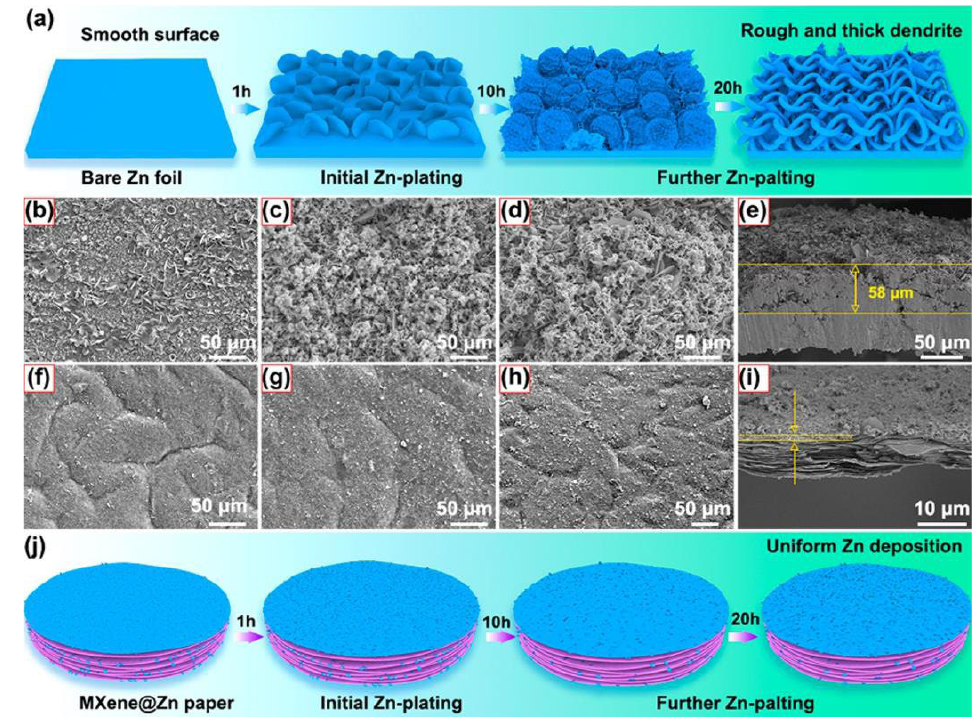
Figure 22. Morphological evolution and schematic illustration of Zn deposition. Schematic deposition on the ( a ) Zn foil and ( j ) Ti 3 C 2 T x MXene@Zn paper. Typical top-view SEM images of Zn deposition in 2 M ZnSO 4 electrolyte after plating capacity of ( b ) 1, ( c ) 10, and ( d ) 20 mAh · cm − 2 on Zn foil, and ( f ) 1, ( g ) 10, and ( h ) 20 mAh · cm − 2 on Ti 3 C 2 T x MXene@Zn paper at a current density of 1 mA · cm − 2 , respectively. Cross-sectional SEM images of ( e ) commercial Zn foil and ( i ) Ti 3 C 2 T x MXene@Zn paper corresponding to panels d and h, respectively. Reprinted with permission from [72]. Copyright 2019 American Chemical Society.